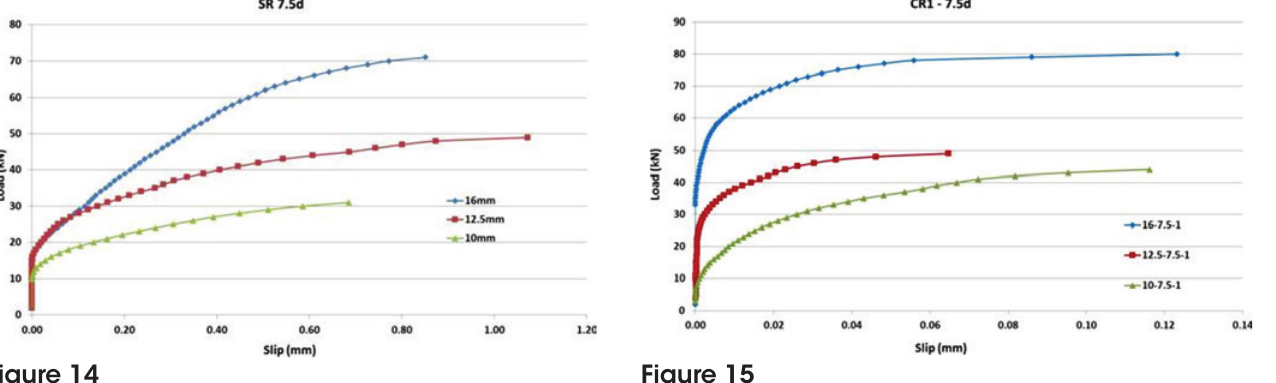
Influence of the bar diameter, models: 10-7.5-0; 12.5-7.5-0 and 16-7.5-0